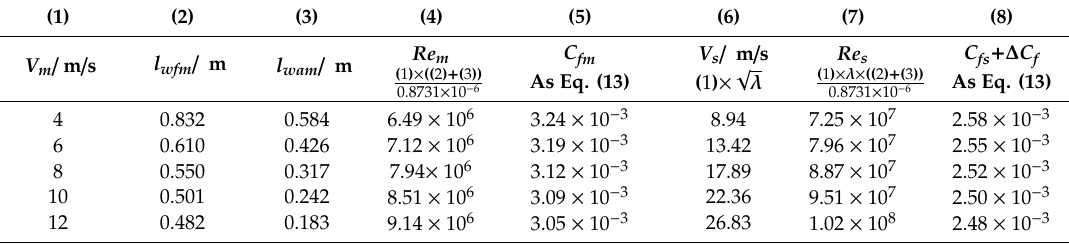
Table 4. The friction resistance coe ffi cients based on two-dimensional